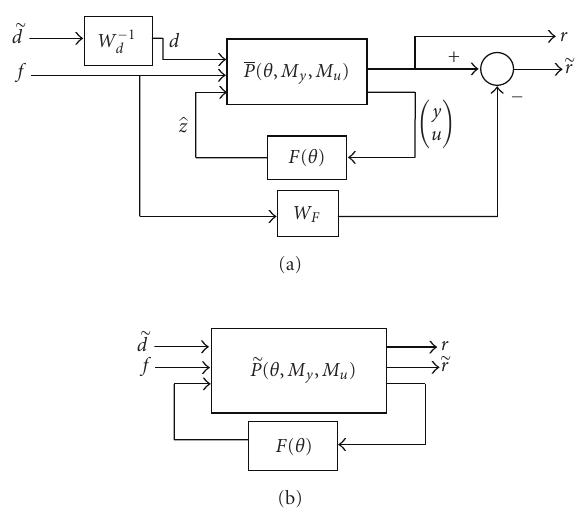
Figure 4: Fictitious quadratic H ∞ formulation for the filter design